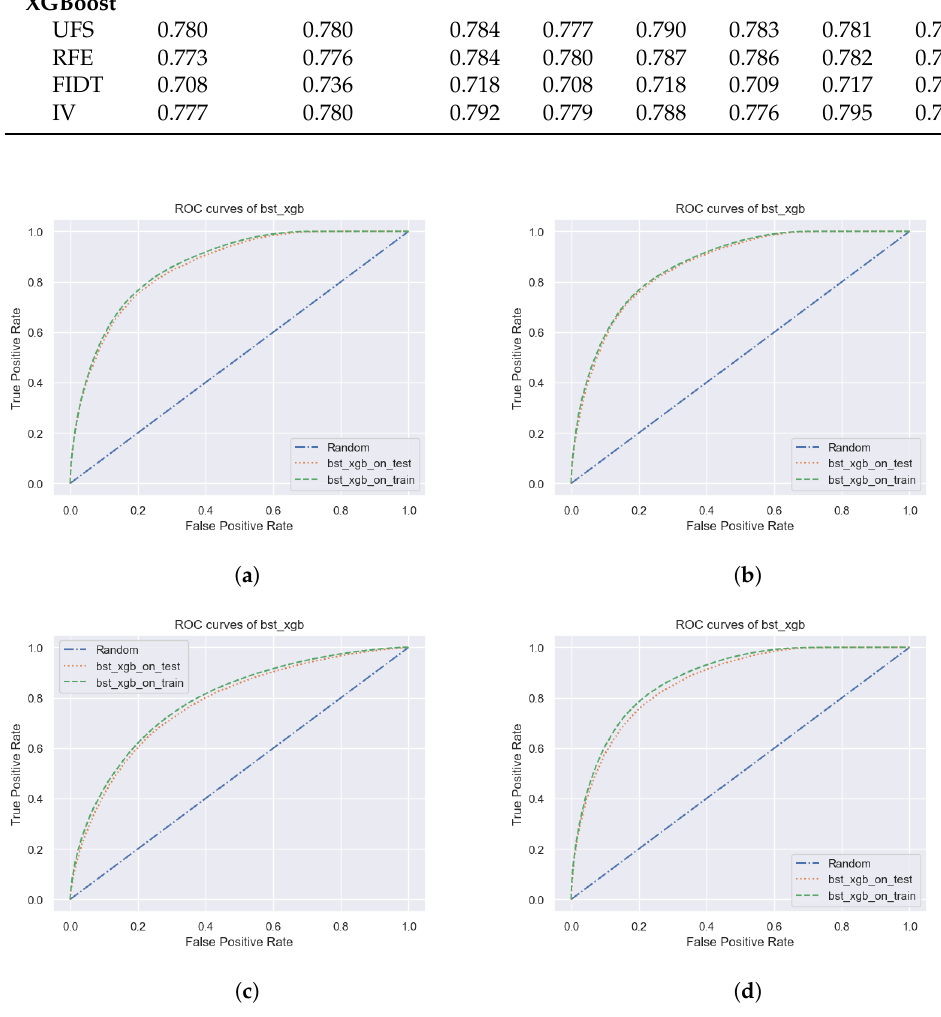
Figure 1. ROC Curves of the XGBoost models based on different features selection